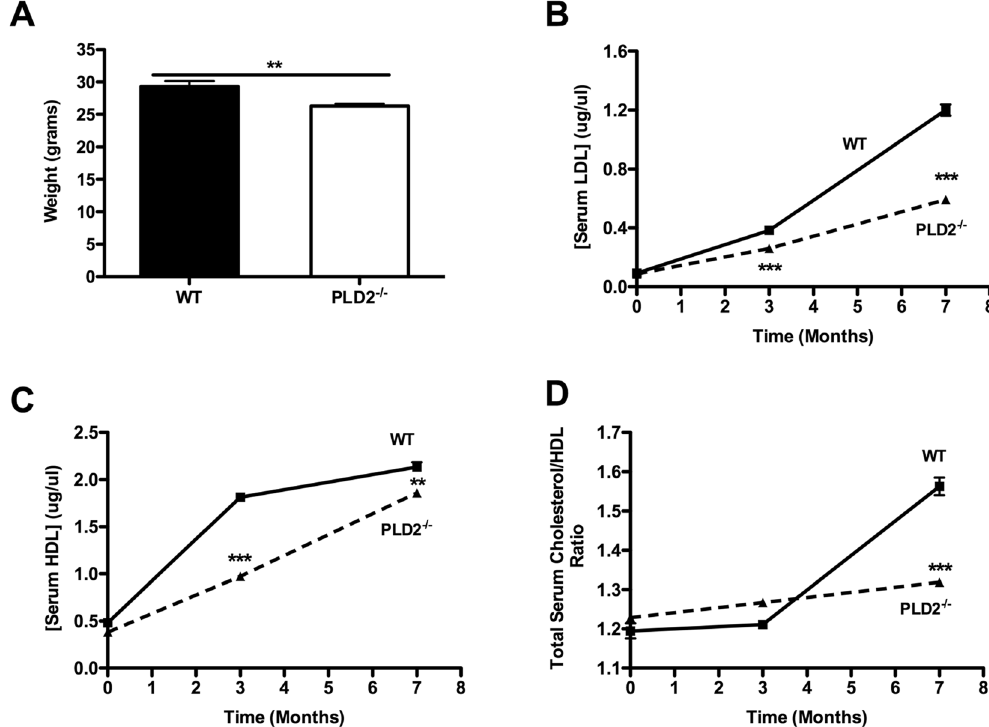
Figure 2. PLD2 − / − mice are neither obese nor hyperlipidemic. ( A ) weight at 5 months, n = 7 mice of each genotype. LDL ( B ), HDL ( C ), and total serum cholesterol/HDL ratio ( D ) after 0, 3 and 7 months on a high fat diet (n = 3 mice of each genotype). Mean ± SEM; ** p < 0.01; *** p ≤ 0.001 (Student’s